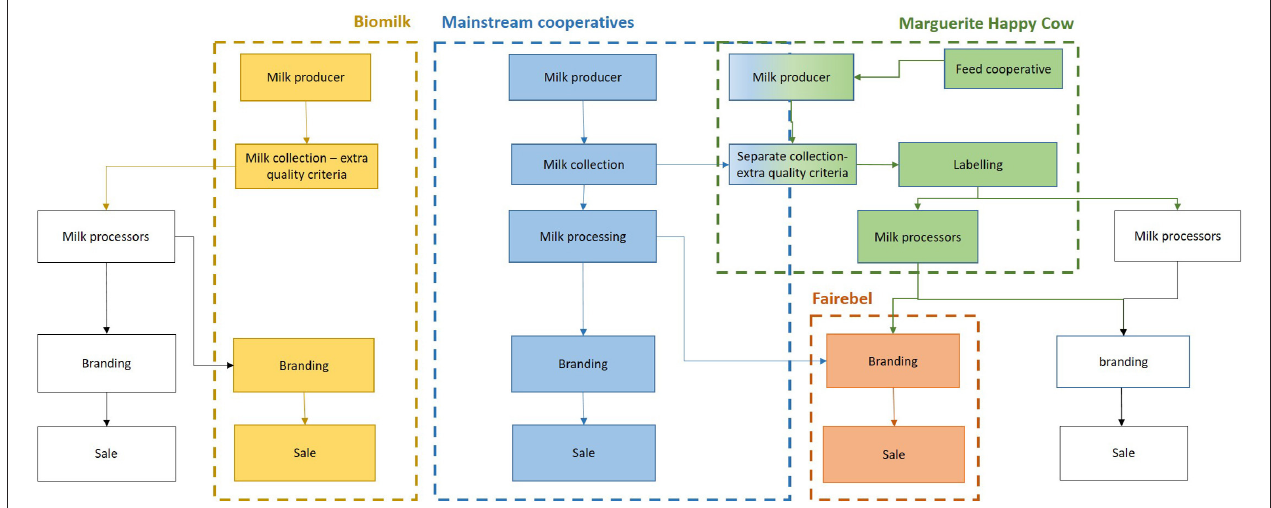
FIGURE 1 | Graphical overview of the studied cooperative models—the arrows represent the product fluxes.